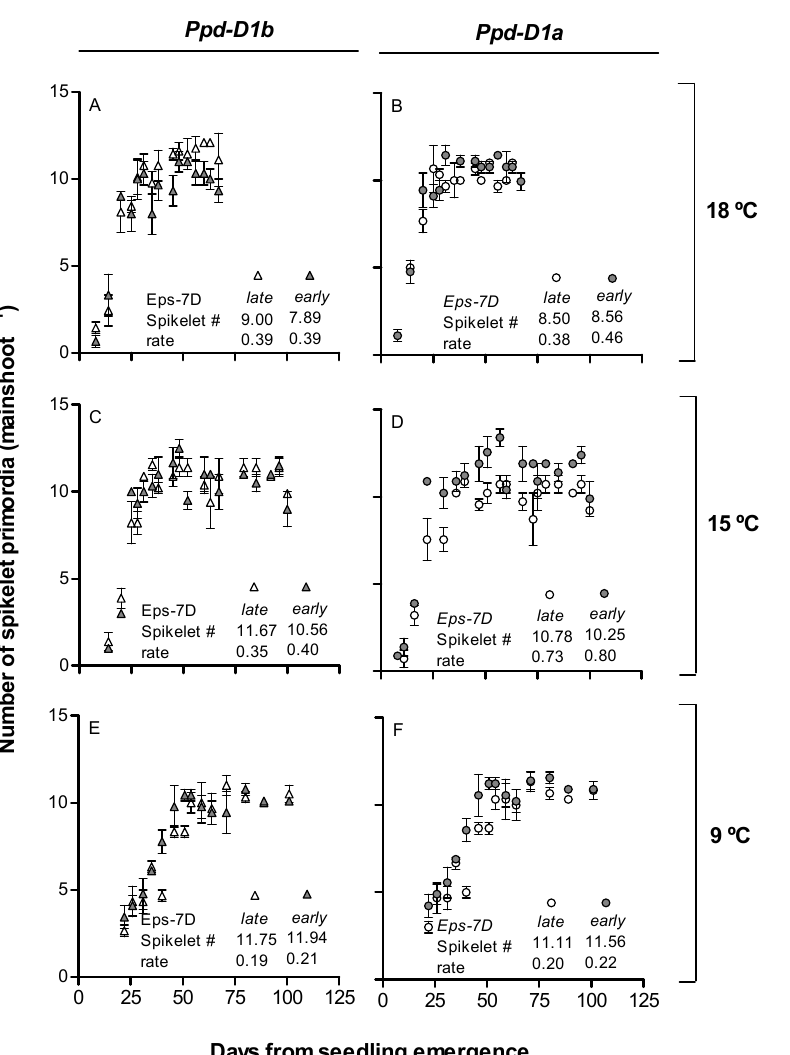
Figure 4. Dynamics of spikelet initiation for Eps-7D-late (open symbols) and -early (closed symbols) for the lines carrying the Ppd-D1b ( A , C , E , triangles) or Ppd-D1a ( B , D , F , circles) alleles in the background when grown at 18 ( A , B ), 15 ( C , D ) and 9 °C ( E , F ). The inset of each panel consists of the final number of spikelet primordia as well as the estimated rate of spikelet initiation (slope of the relationship until reaching TS; spikelet primordia per day).